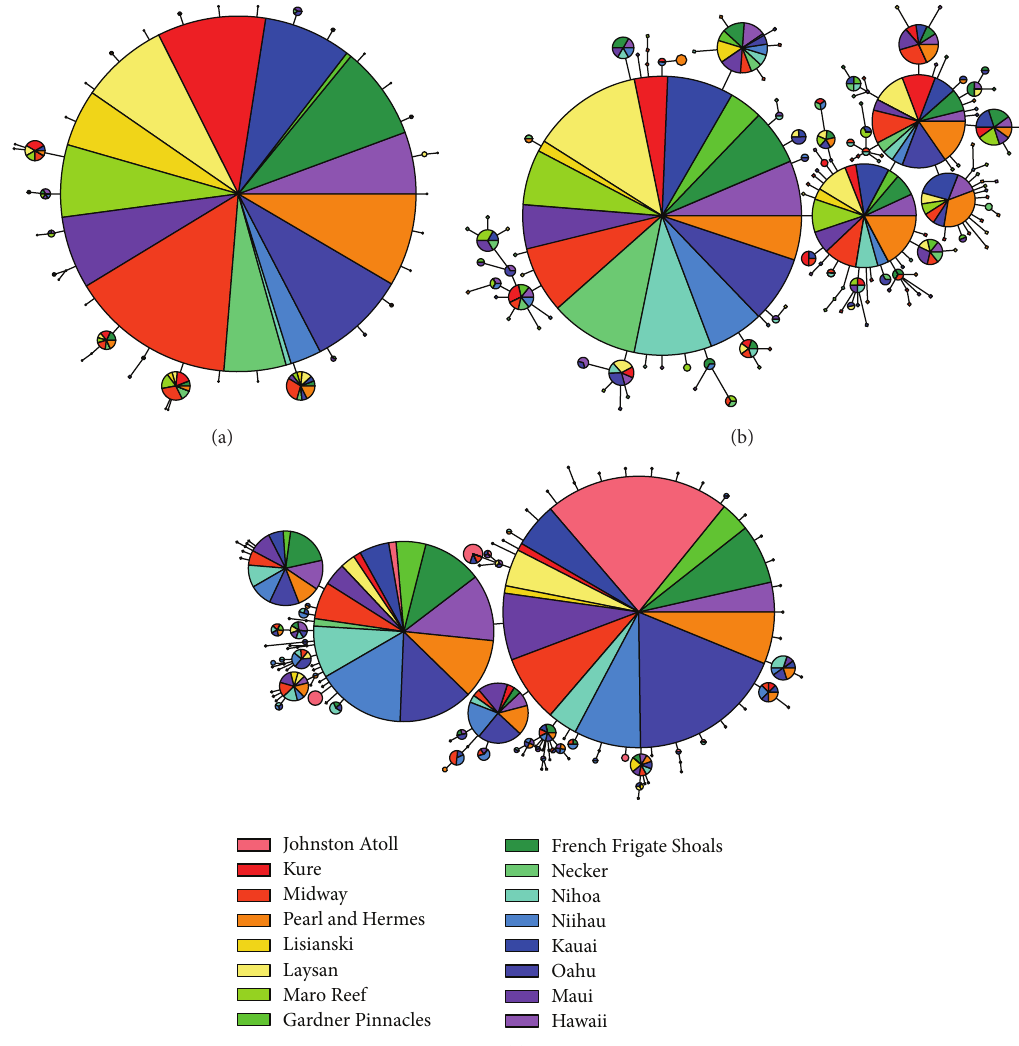
Figure 2: Parsimony-based haplotype networks using cyt b sequence data for (a) A. abdominalis , (b) C. ovalis , and (c) C. verater . Each circle represents a haplotype and is proportional to the frequency of that haplotype. Length of branches is proportional to number of mutations. Networks are color-coded by sampling location and are not scaled relative to each